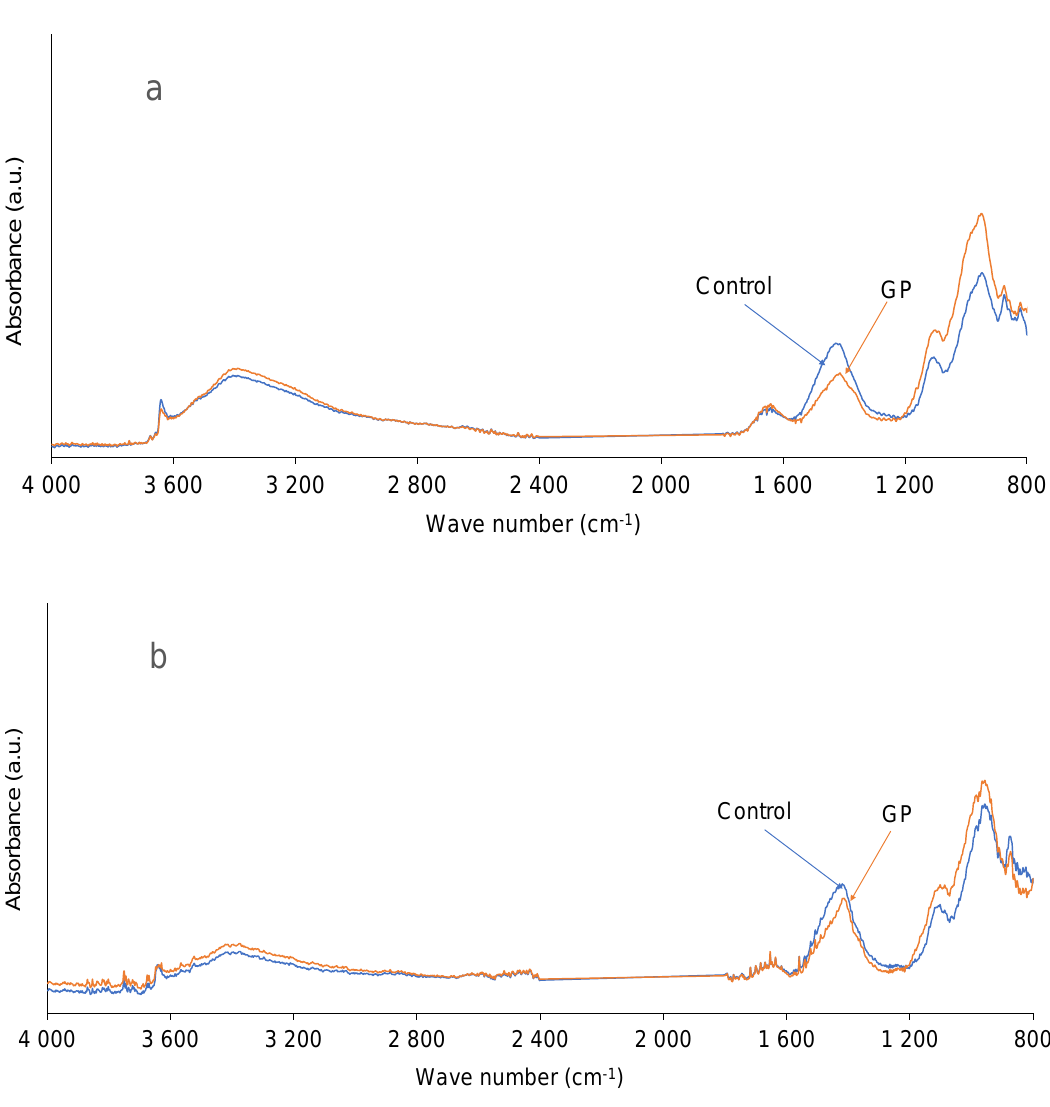
Figure 5. FTIR spectra of control and GP pastes at 14 ( a ) and 28 ( b ) days.